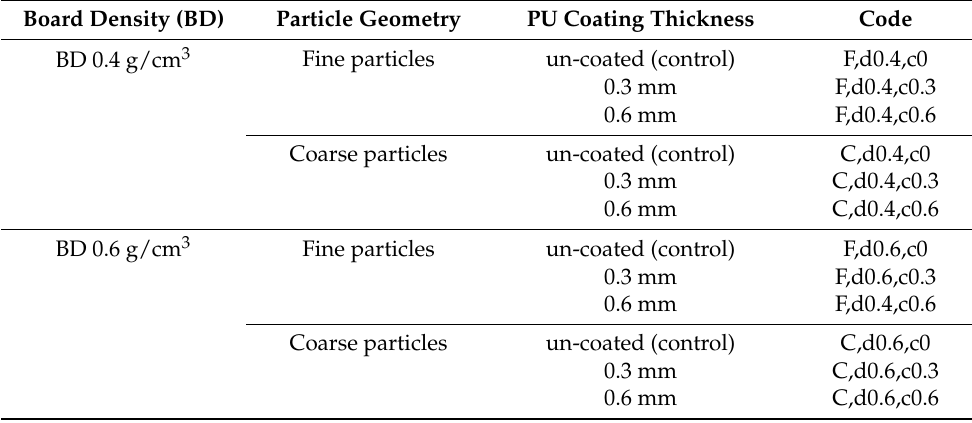
Table 1. Sample condition in experimental